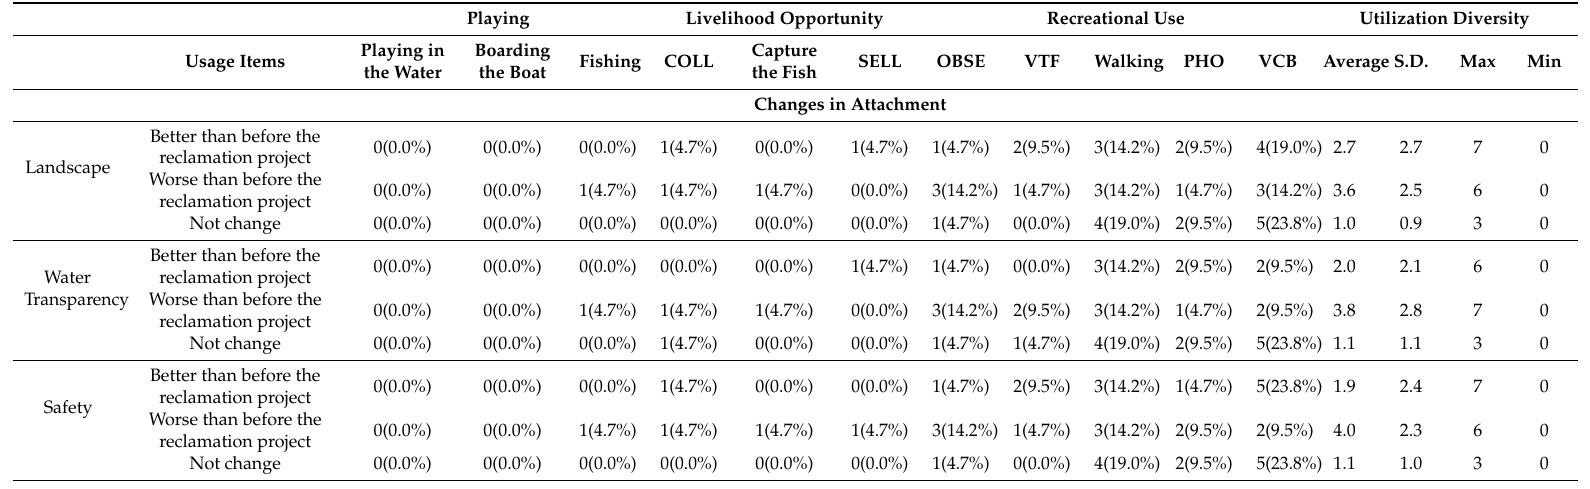
Table A7. Changes in attachment towards the Fukushima-gata lagoon and actual use situation of the Fukushima-gata lagoon after reclamation project (n = 21).